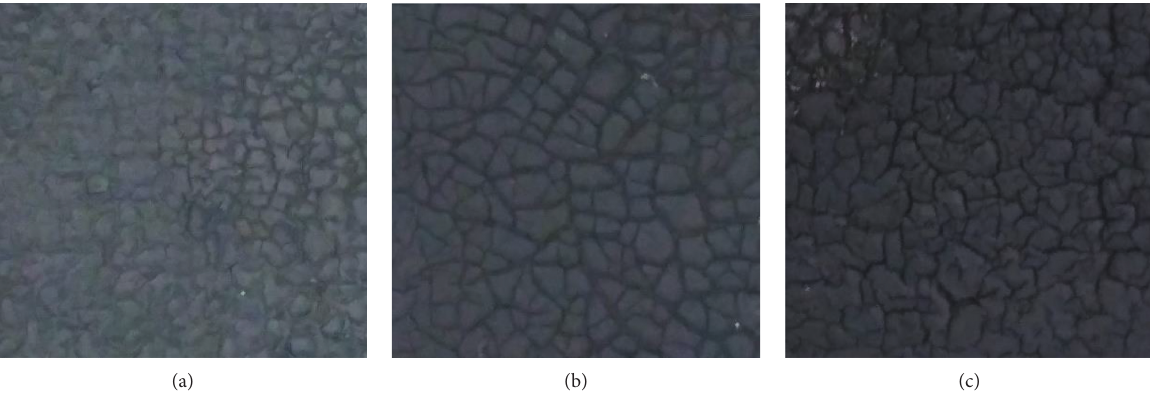
Figure 7: Photographs of the surface of the electrode-coated CI-NBA (1/1) (a), CI-NBA (1/0.5) (b), and CI-NBA (1/2)